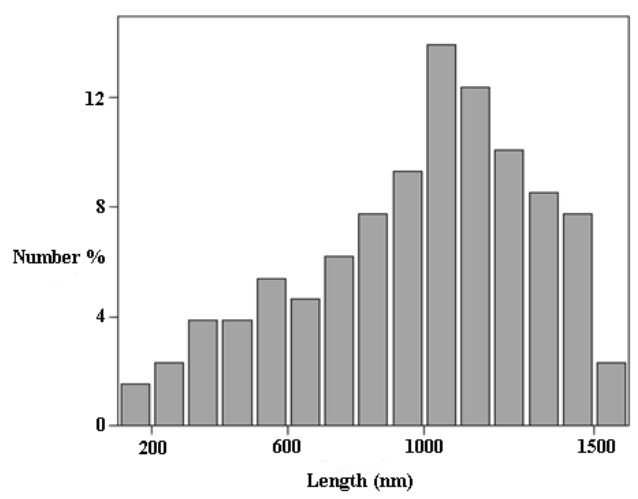
Figure 2. SWCNT size distribution function based on TEM for a SDS/stabilized dispersion (0.1 wt% in 1.00 wt% SDS). Mesh size is 100 nm; lengths > 1600 nm are not reported. The RMS length is 1235 nm and the standard deviation 570: the nominal one is 1000 nm.